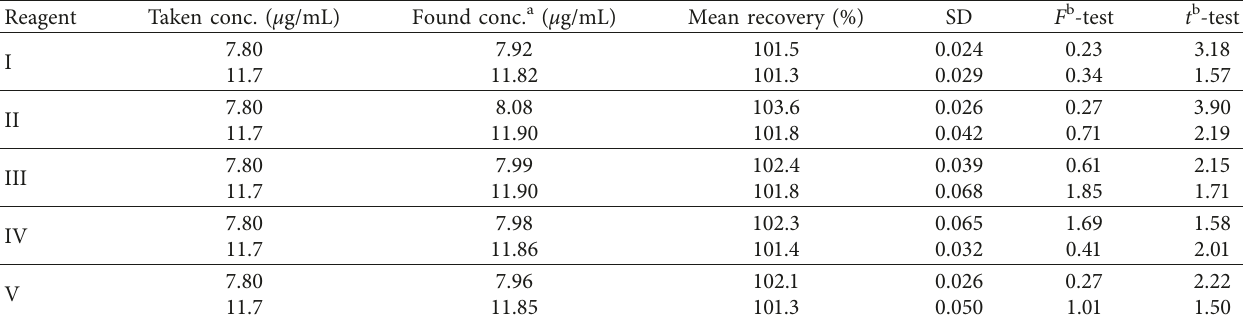
Table 5: Determination of diaveridine in pharmaceutical preparation (New-Cox). Reagent Taken conc. ( µ